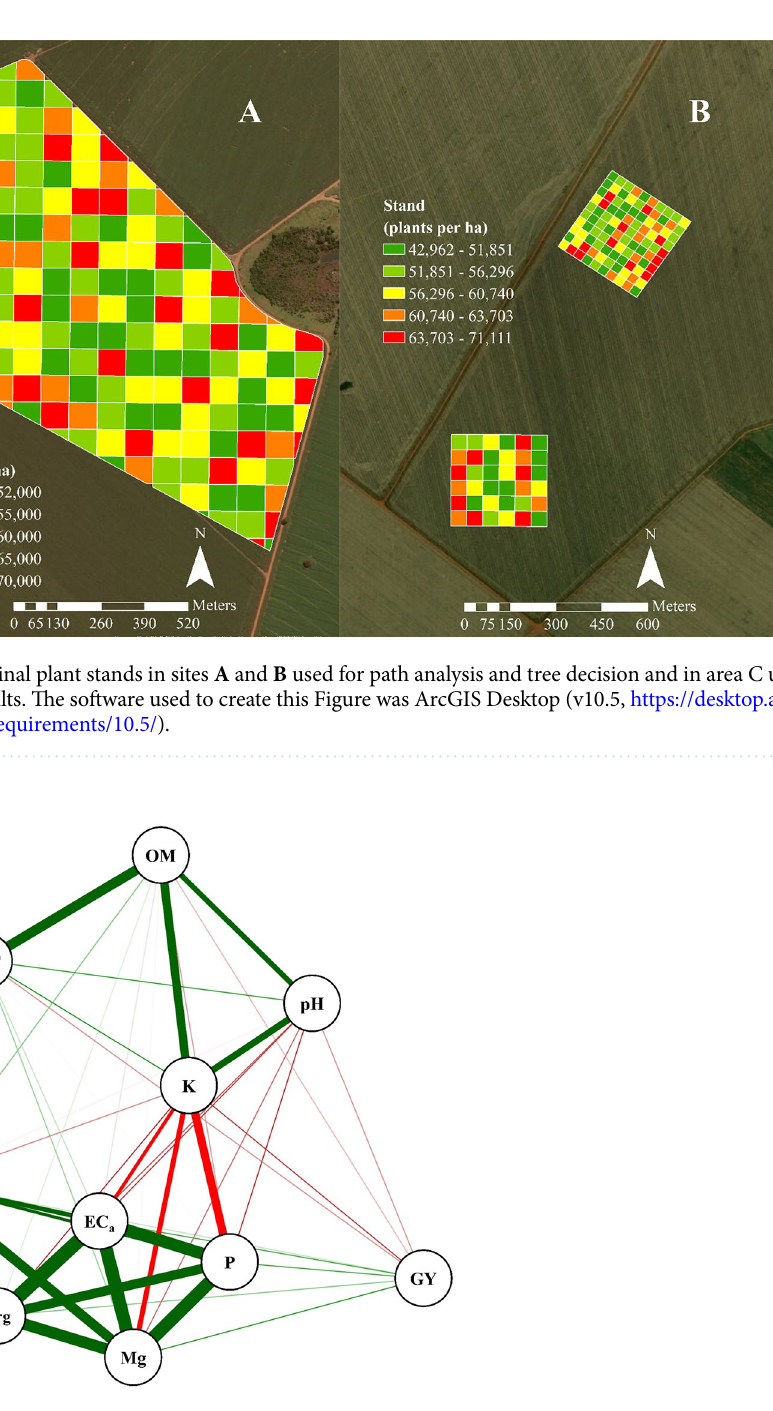
Figure 5. Pearson correlation network between soil attributes pH, calcium (Ca), magnesium (Mg), cation exchange capacity (CEC), potassium (K), phosphorus (P), organic matter (OM), clay, apparent electrical conductivity (EC a ), and grain yield (GY). The package used of R to create this figure was qgraph (v1.6.9, https:// cran.r- proje ct. org/ web/ packa ges/ qgraph/ index.